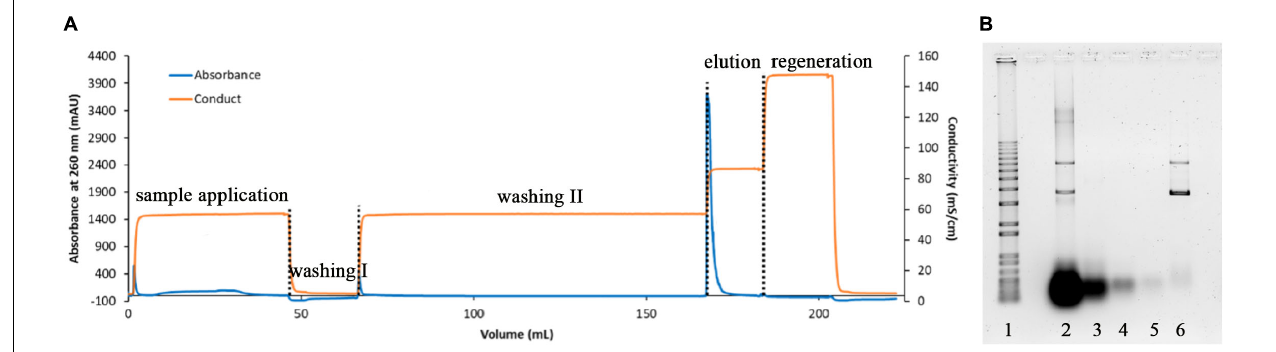
FIGURE 1 | Chromatogram of the DEAE capture step (A) and respective agarose electrophoresis (B) where lane 1 is 1 kb plus DNA ladder, lane 2 lysate, lane 3 after RNA precipitation, lane 4 AIEX flow through fraction, lane 5 AIEX washing II fraction, and lane 6 AIEX elution fraction.